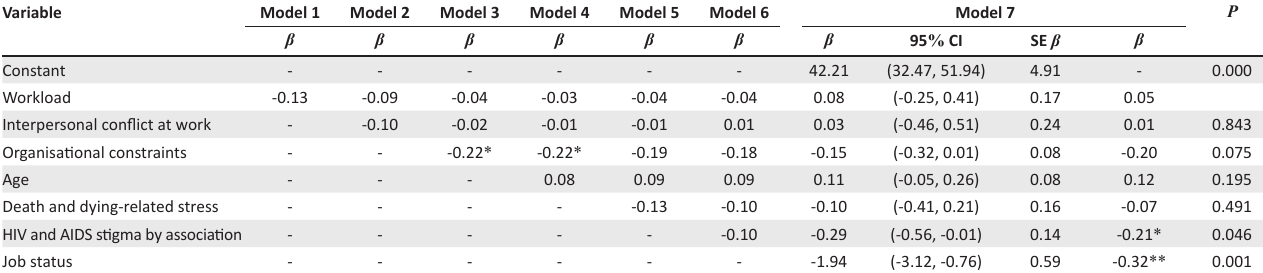
TABLE 6: Predictors of personal accomplishment.